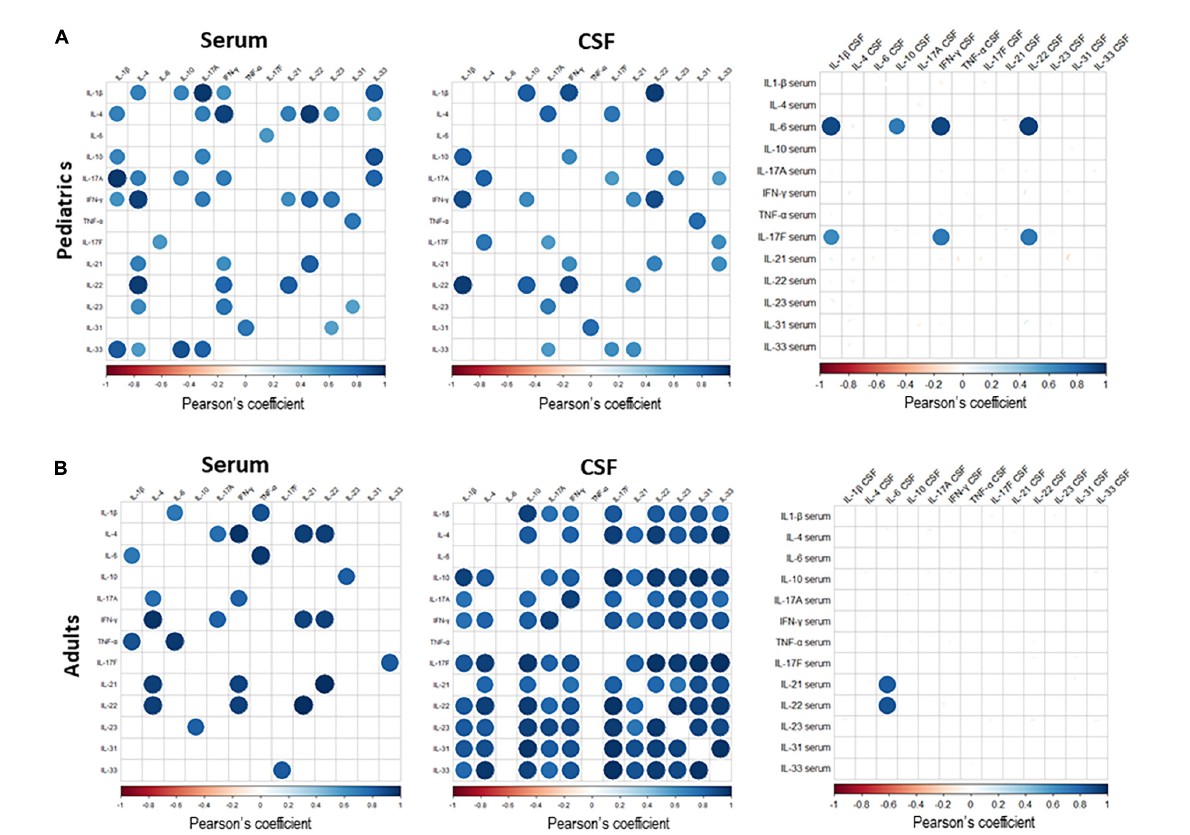
FIGURE7 The correlation matrix among all cytokines expressed in serum and cerebrospinal fluid (CSF) of pediatric (A) and adult (B) Spinal muscular atrophy (SMA) patients. Pearson’s correlation coefficients r ≥ 0.5 or ≤ 0.5 are shown. White squares lack statistical significance ( p > 0.05). The color in each circle indicates the Pearson’s correlation coefficient r among the variables reported in the two coordinates, as indicated by colored scale